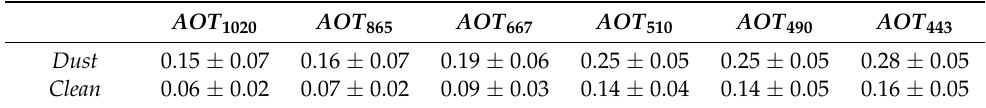
Table 1. Values of average aerosol optical thickness on the days of WRF-Chem dust forecast